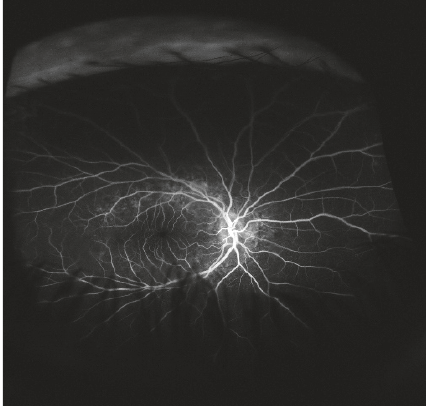
Figure 2: Fundus fluorescein angiography in later phases showing hyperfluorescent deposits in the posterior pole without